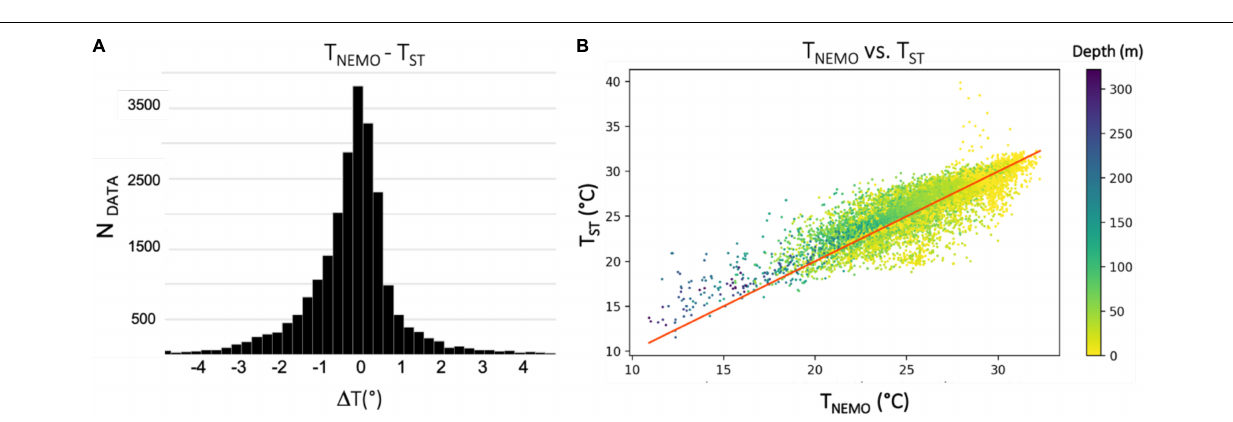
FIGURE 9 | As in Figure 7 , but for (A) Histogram and (B) scatterplot of differences between Glo12 (TN EMO ) and ST (T ST ) temperature between 0 and 320 m